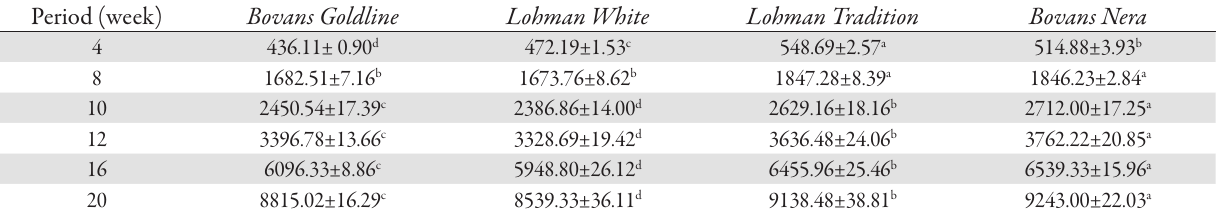
Tab. 1. Average feed intake of growing pullet strain on same diet Period (week)